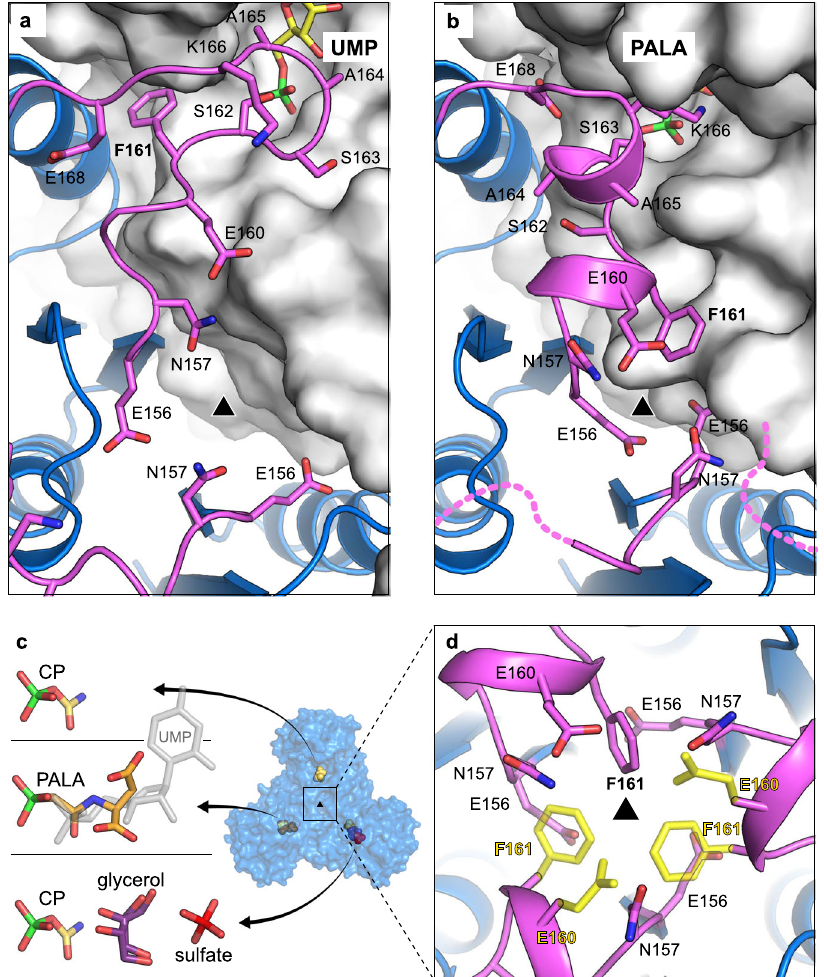
Fig. 4 The CP-loop folds in two different conformations for UMP or PALA binding. a , b Cartoon representation of the CP-loop (in magenta) over the active site of the adjacent subunit (shown in surface representation) bound to UMP ( a ) or PALA ( b ). c Structure of atATC with one subunit bound to PALA, a second one with CP, and the third having CP, glycerol, and one sulfate ion. A UMP molecule is shown in semitransparent gray to compare the position relative to the ligands. d Detail view along the three-fold axis. The side chains of E160 and F161 are only seen in one subunit. Modeling of these two residues in the other two subunits (shown in yellow semitransparent representation) causes steric clash and charge